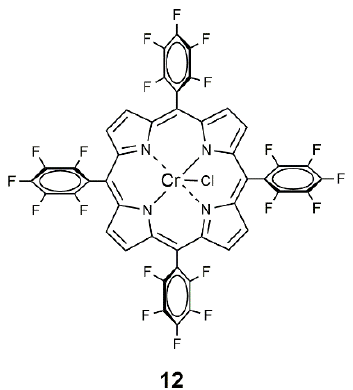
Figure 6. The (porphyrin)Cr(III)Cl complex 12 employed by Chisolm and coworkers [30]. A major breakthrough in this field was the use of the single component Co(III) complex 13 (Figure 7) tethering four quaternary ammonium salts [31].